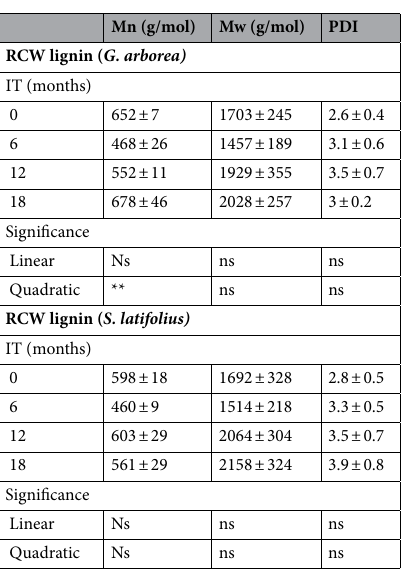
Table 5. Polymer properties of organosolv lignins isolated from the G. arborea and S. latifolius RCW at 0 (RCW0), 6 (RCW6), 12 (RCW12) and 18 (RCW18) months residence in soils. Mn, number-average; Mw, weight-average; PDI, polydiversity index, results are expressed as mean ± standard error in triplicate; RCW Incubation times (months) in soil; Results are expressed as means ± standard errors in triplicate; **Contrasts significant at the 0.01 level, ns = not